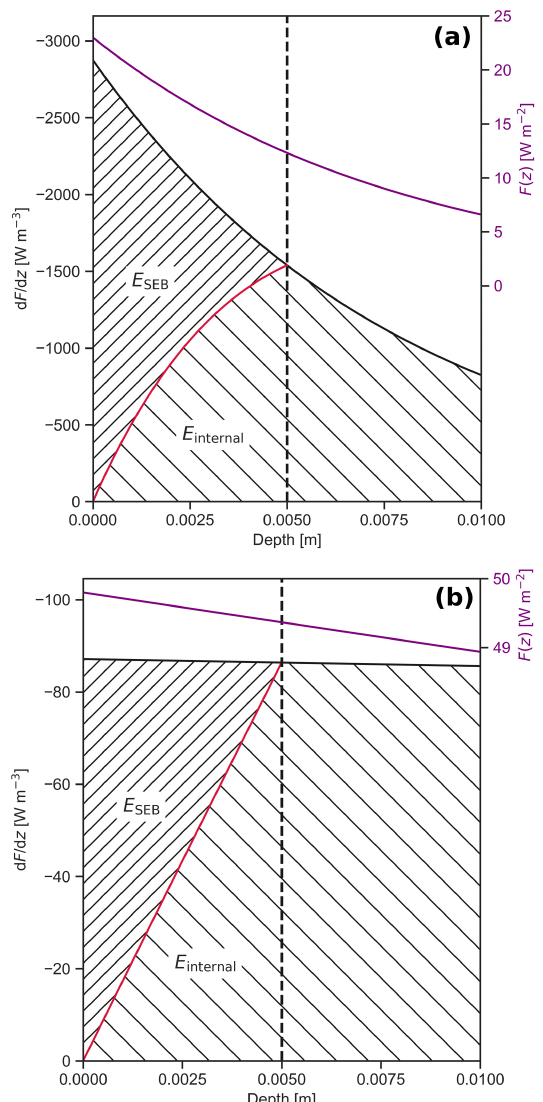
Figure 1. Net downward shortwave radiation F(z) (purple), d F(z)/ d z ; absorbed energy contributing to the SEB ( E SEB ), indi- cated by the area above the red curve with dense hatches; and inter- nal energy absorption ( E internal ), indicated by the area under the red curve with sparse hatches, as a function of depth for (a) a fresh snow layer and Rp3’s spectral band 6 (778–1242nm) and (b) an ice layer for band 4 (442–625nm). The vertical dashed line shows the 5mm skin layer equilibration depth (SLED). Here, we assume typical net downward shortwave radiation at the surface and τ = 0 . 008m for panel (a) (Meirold-Mautner and Lehning, 2004) and τ = 0 . 56m for panel (b) (Cooper et al., 2020). All absorbed energy beyond z sled is